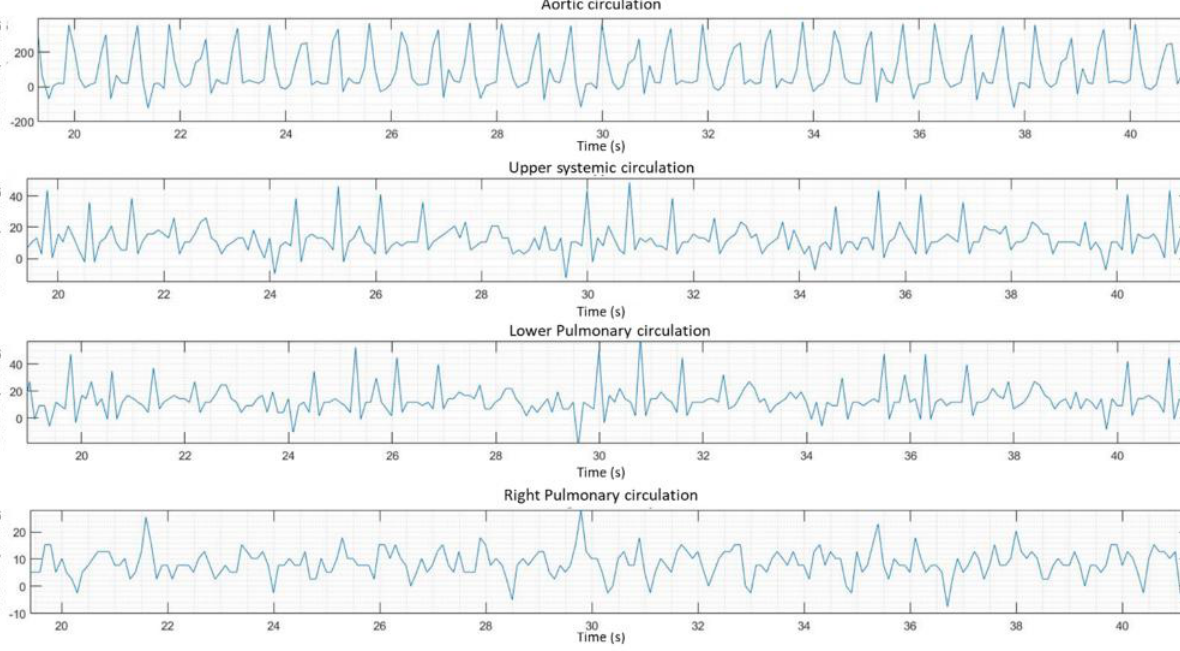
Figure 16 . Unfiltered pressure waveform for 3 mm IJS with a reduced PVR of 30%.